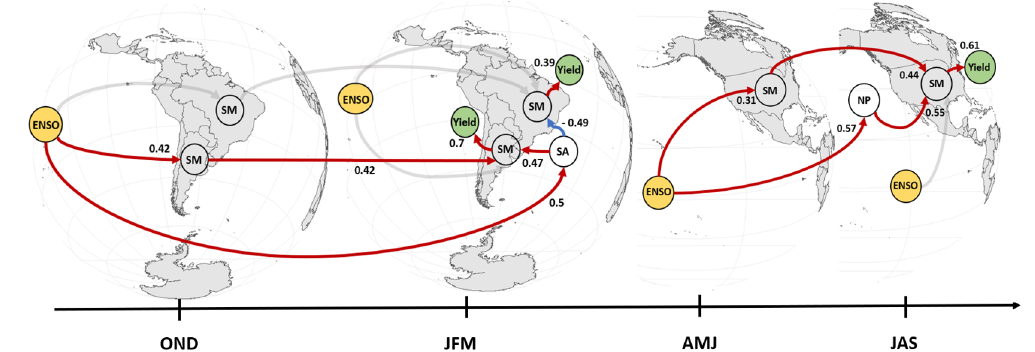
Figure 5. Structural equation models showing assumed hypothesis linking ENSO variability in OND, JFM, AMJ and JAS to yield anomaly in CB, SESA and US regions. Red arrows show positive significant relationships while blue arrows show negative significant relationships ( P < 0 . 05) between variables. Gray arrows show insignificant relationships ( P > 0 . 05). SM stands for soil moisture, SA stands for South Atlantic pattern, and NP stands for North Pacific